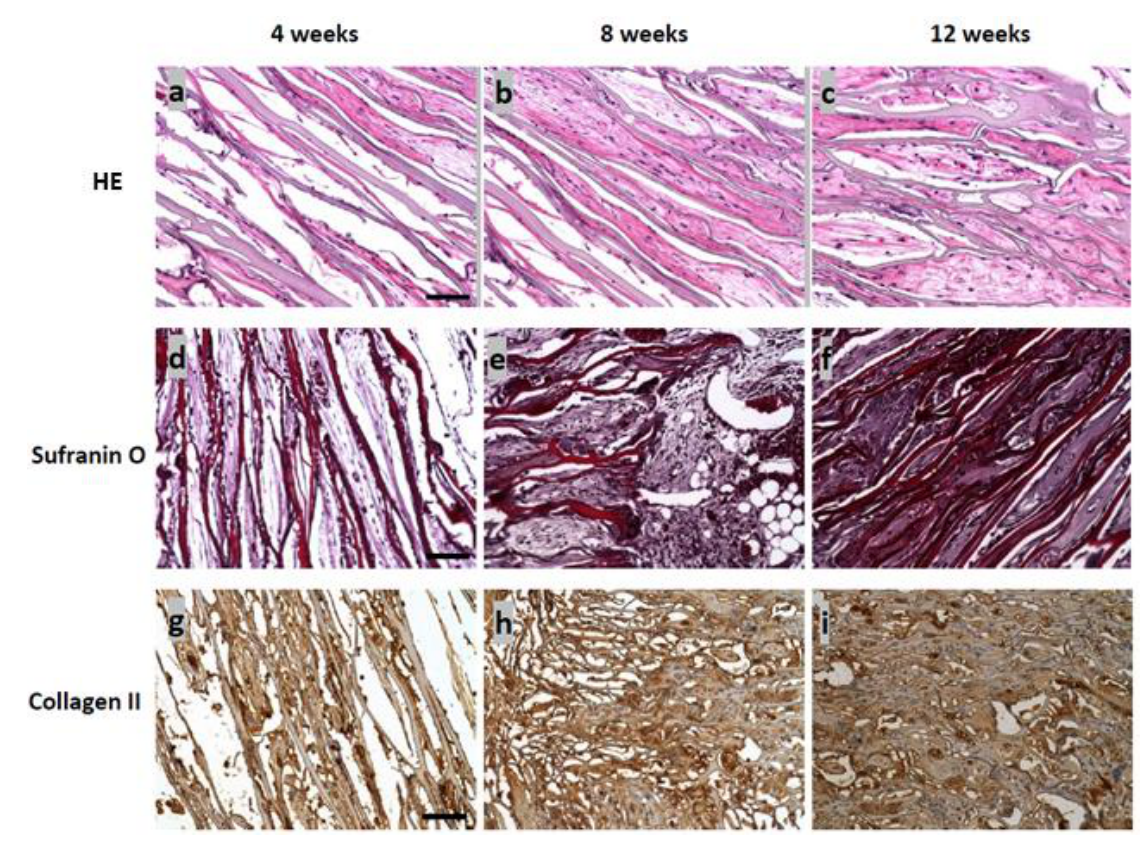
Figure 6. Histological analysis of the SF scaffold-chondrocyte constructs after 4, 8 and 12 weeks of subcutaneous implantation in nude mice (bar = 200 µm). Row 1: Hematoxylin and eosin (HE) stain; Row 2: Safranin O stain; Row 3: immunohistochemical stain of collagen